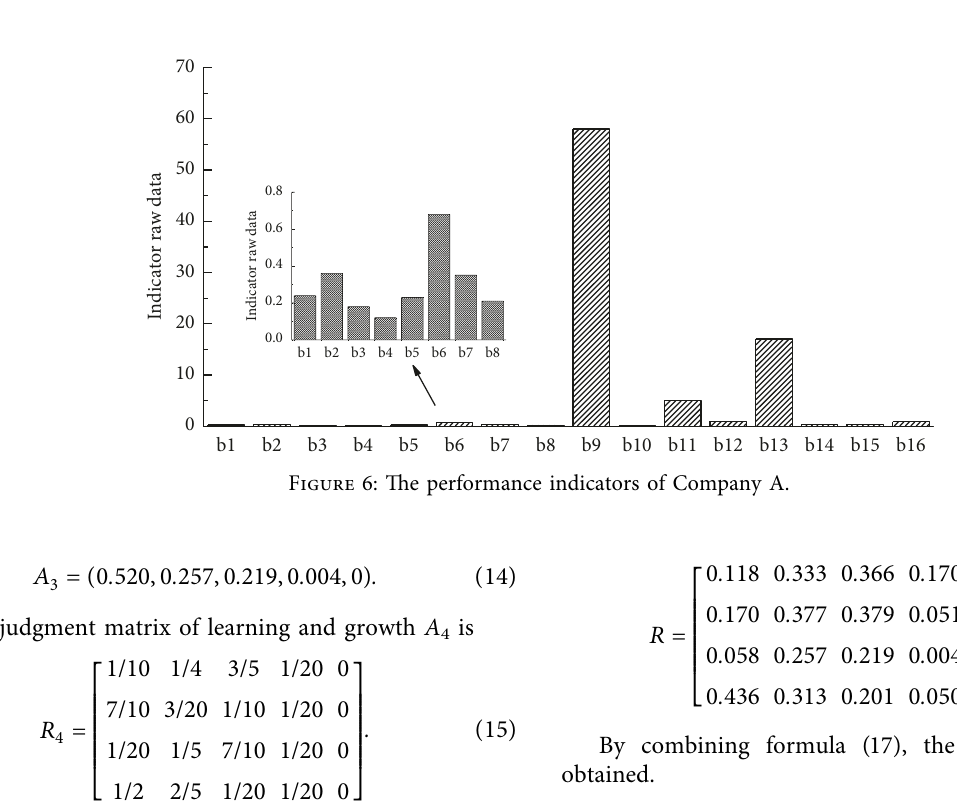
Figure 5: The weight of each layer index and the total ranking weight.